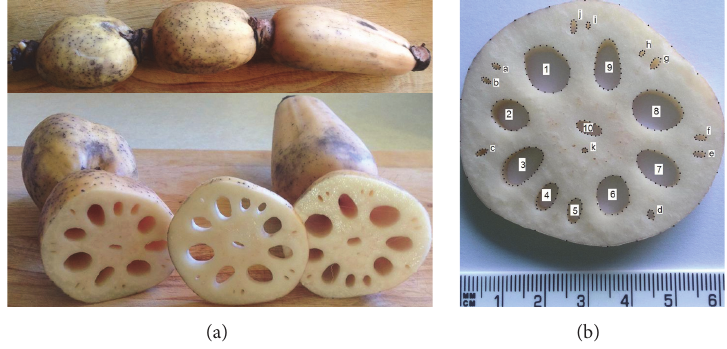
Figure 1: (a) Lotus roots and (b) a slice of lotus root used for the analysis.